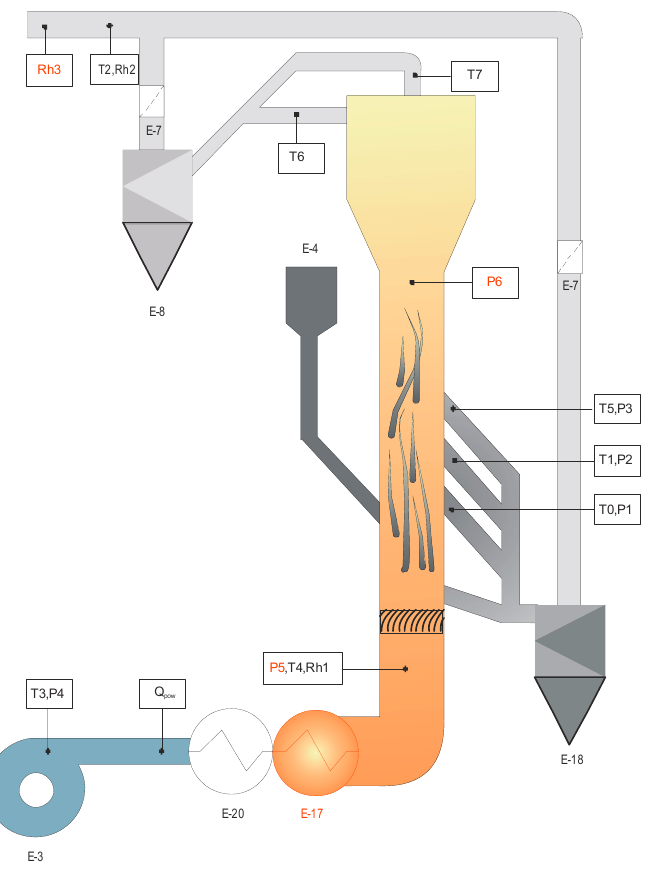
Figure 1. Torbed Figure 1. Torbed installation—diagram.